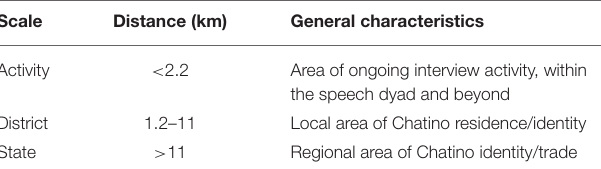
TABLE 3 | Scales for search domains, with their characteristics.